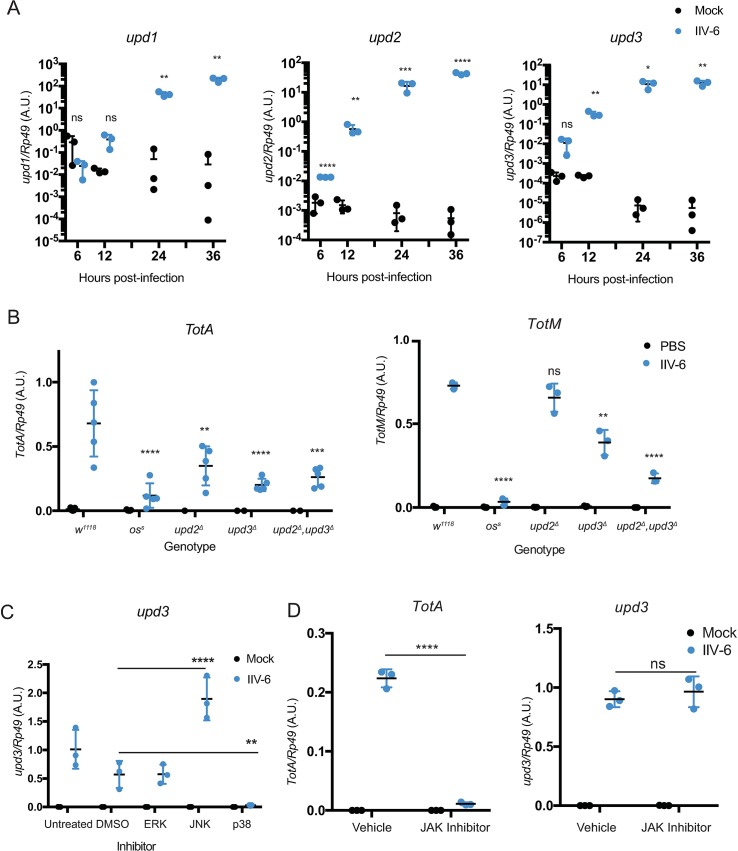
p38-dependent IIV-6 induced unpaired expression A) S2* cells were infected with IIV-6 for the indicated times and induction of upd1, upd2, or upd3 was monitored by qRT-PCR, compared to PBS injected controls. Three biologically independent replicates are shown and statistical analysis was performed by Multiple t-tests with the Holm-Sidak correction for multiple comparisons. Error bars indicate standard deviation and black bars indicate the mean. B)
TotA or TotM expression was measured by qRT-PCR from control w1118 flies as well as outstretcheds (oss), upd2Δ, upd3Δ, or upd2Δ,3Δ mutant flies 24 hours after IIV-6 infection or PBS injection. The results of 3–5 biologically independent assays are displayed. Error bars represent the standard deviation and black bars represent the mean. Statistical significance compared to the IIV-6 infected control strain (w1118) was determined by two-way ANOVA with Holm-Sidak correction. C) S2* cells were treated with inhibitors for the three MAPKs: JNK (SP600125, 25μΜ), ERK (U0125, 10μΜ), and p38 (SB203580, 10μΜ), or treated with a vehicle control (DMSO), for one hour prior to IIV-6 infection or mock treatment. After 24 hours of infection, upd3 expression was assayed by qRT-PCR. The results of 3 biologically independent assays are shown. Statistical significance, compared to the DMSO treated control, was determined by two-way ANOVA with Holm-Sidak correction. D) S2* cells were treated with the JAK inhibitor Tofacitinib (CP690,550 10 μM), or treated with a vehicle control (DMSO), for one hour prior to IIV-6 infection or mock treatment. After 24 hours of infection, TotA and upd3 expression were assayed by qRT-PCR. 3 biologically independent assays with statistical significance, comparing virus infected vehicle to inhibitor treatments, determined by two-way ANOVA with Holm-Sidak's multiple comparisons test. Significance is indicated in A-D as * p < 0.05; ** p < 0.01; *** p < 0.001; **** p < 0.0001; and ns, not significant. A.U., Arbitrary Units.